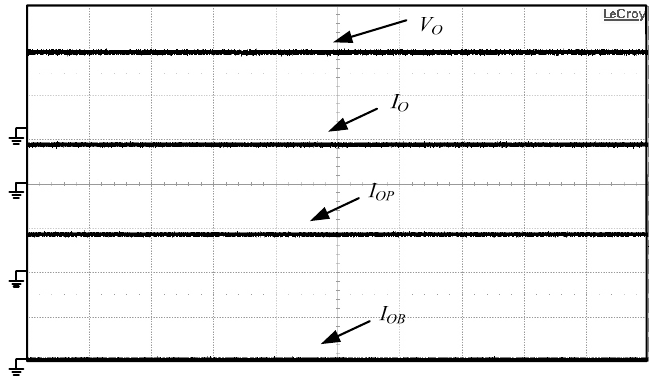
( V : 200 V/div, I O